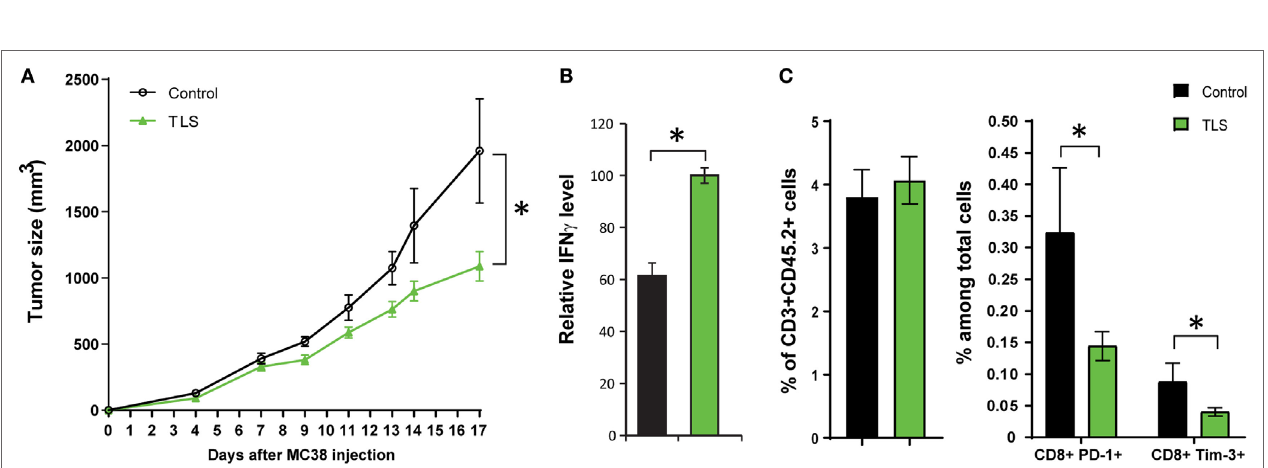
FigUre 4 | The presence of tertiary lymphoid structures (TLSs) suppresses MC38 tumor growth. (a) MC38 tumor growth in control and TLS-bearing mice ( n = 3–15 for control group, n = 3–21 for TLS group at different time points). 1e6 MC38 tumor cells were injected subcutaneously to control and TLS-bearing mice, and tumor size was measured up to 17 days after injection. (B) Tumor-infiltrating lymphocytes (TILs) were isolated from MC38 tumors using CD90.2 microbeads from control and TLS-bearing mice, and incubated with irradiated MC38 cells for 24 and 48 h. Supernatant was collected and tested for IFN γ levels. IFN γ levels were normalized to the TLS group ( n = 8 for control group, n = 18 for TLS group). (c) MC38 tumors from indicated control and TLS-bearing mice were digested and analyzed by flow cytometry. Percentage of CD3 + CD45.2 + cells (TILs) among total live cells was calculated. The expression of immune checkpoint proteins PD-1 and Tim-3 on CD8 + cells was examined from indicated groups ( n = 8 for control group, n = 19 for TLS group). Data are presented as mean ± SE. * p < 0.05.